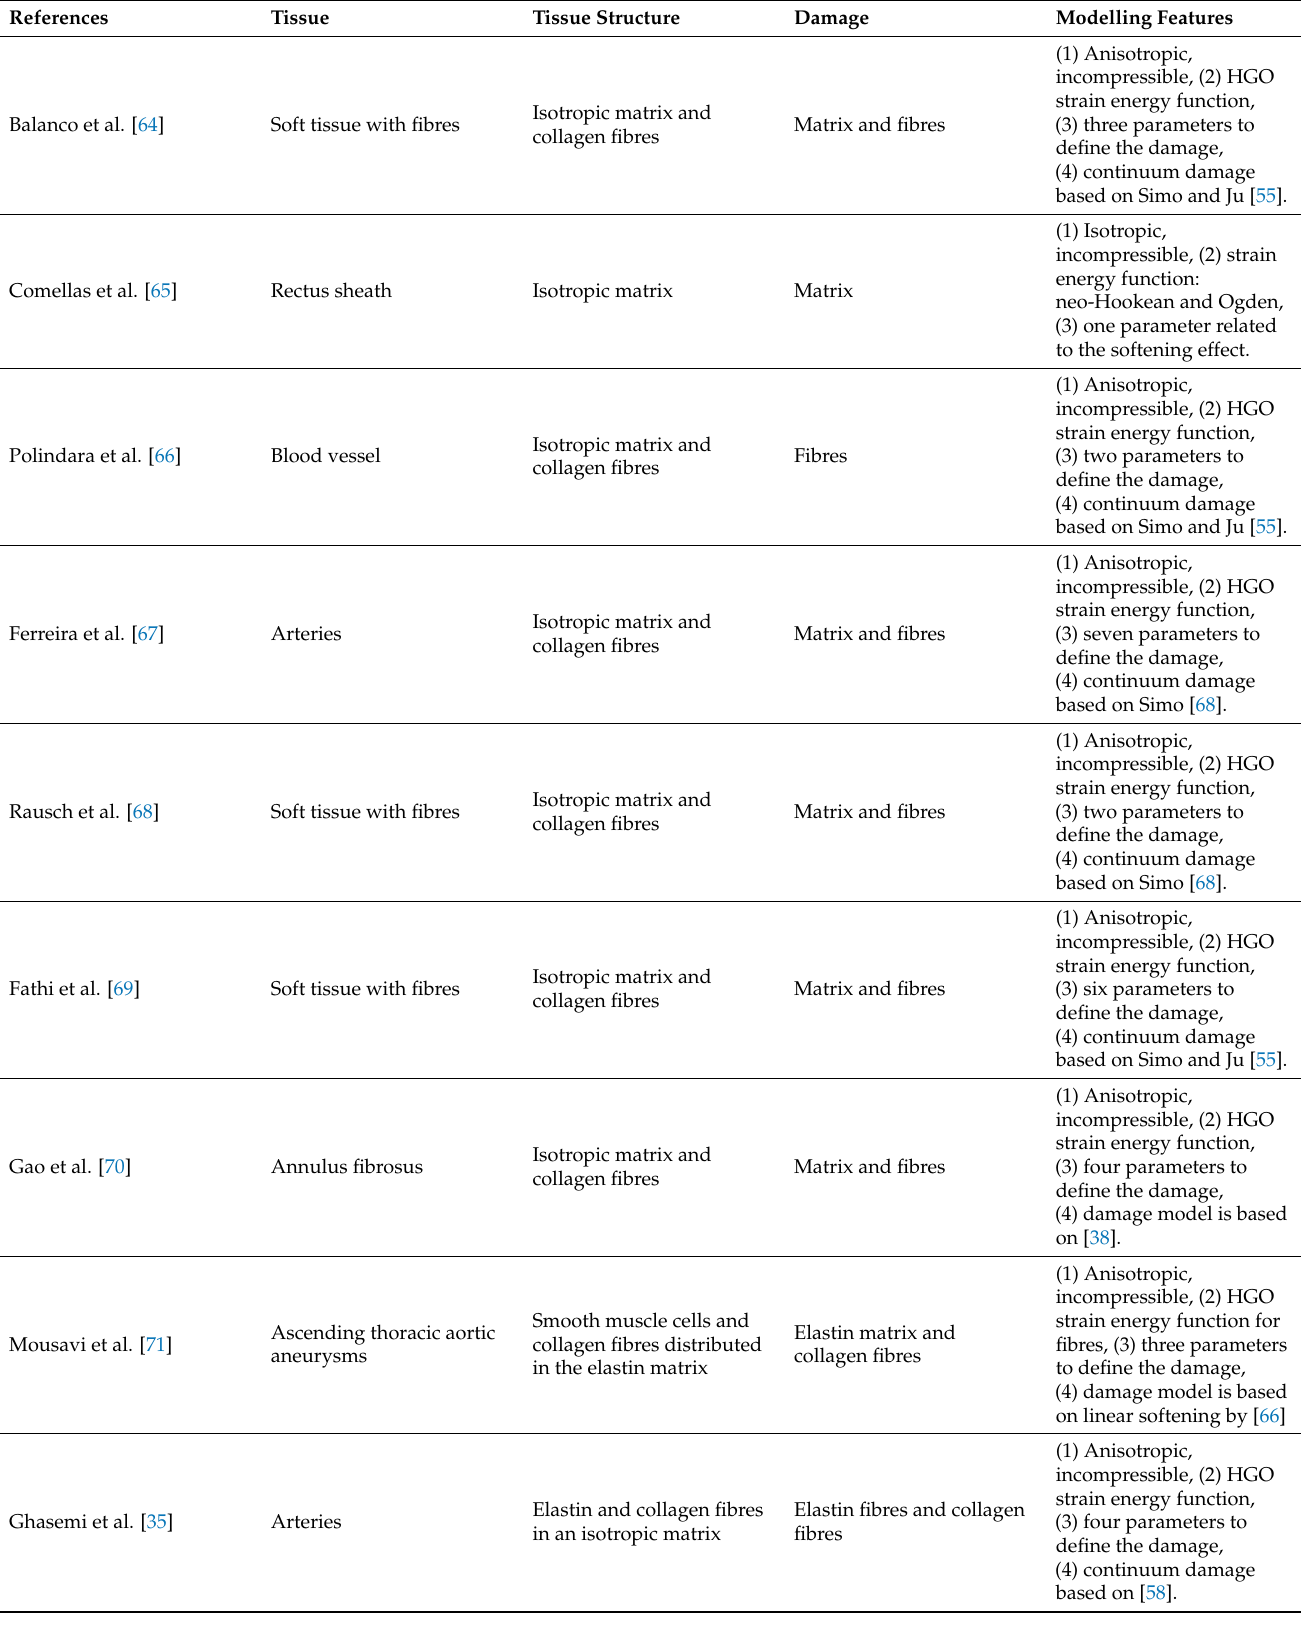
Table 2. Summary of various damage models based on continuum damage mechanics